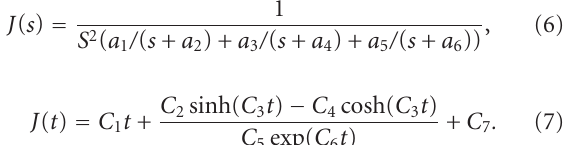
Figure 3: Comparison of creep at 4 di ff erent initial loading rates. The left arrow indicates that a lower reduced creep coe ffi cient is reached at the end of initial ramp loading as the ramp-loading rate increases. The right arrow indicates that a higher creep coe ffi cient is reached after 1500 seconds as ramp-loading rate